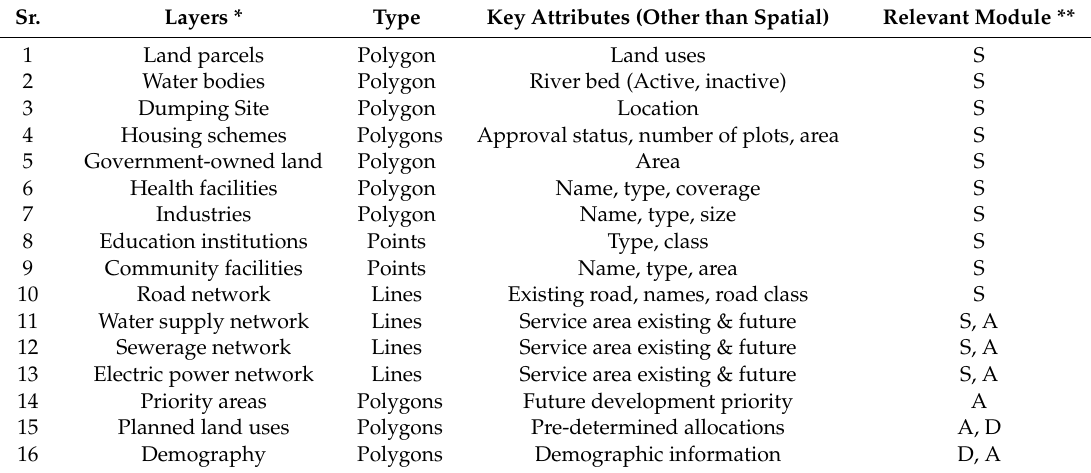
Table 2. Data layers used by the